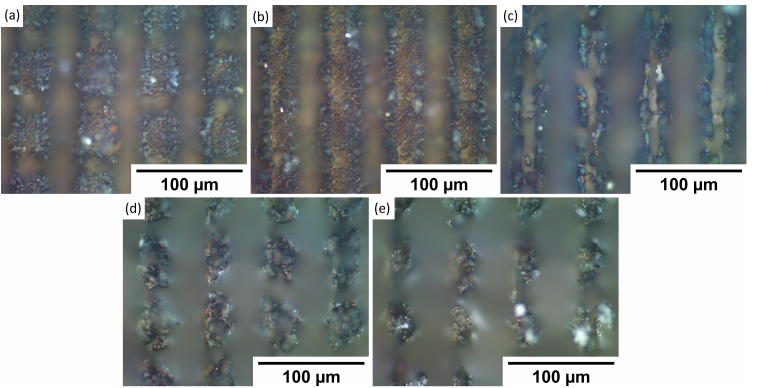
Figure 4. Microscope pictures, with × 50 magnification of each sample groove texture. ( a )—17- 4PH stainless steel, ( b )—PH13 stainless steel, ( c )—Ti6Al4V titanium, ( d )—2024 T3 aluminum, and ( e )—7050 aluminum.